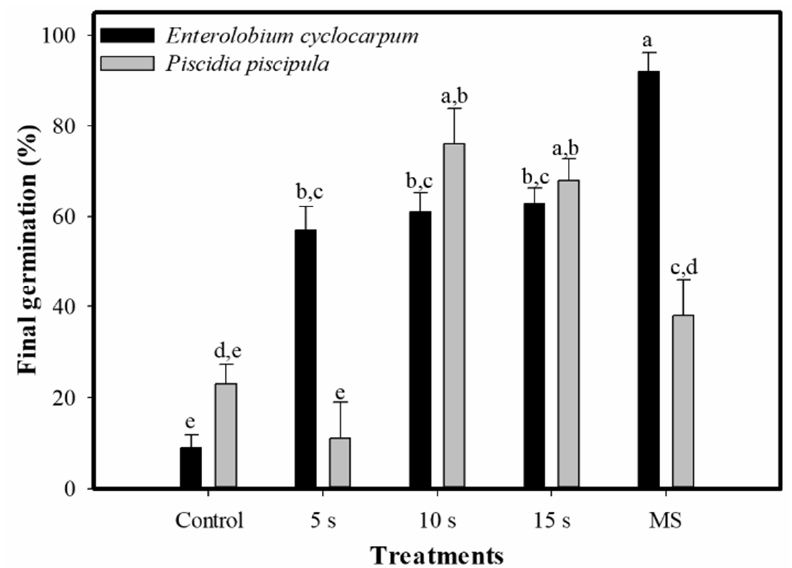
Figure 1. Final germination percentage (mean ± standard error, n = 10) per treatment (boiling water for 5 s, 10 s and 15 s and MS = mechanical scarification) in the studied species. Different letters indicate significant differences between treatments and species.